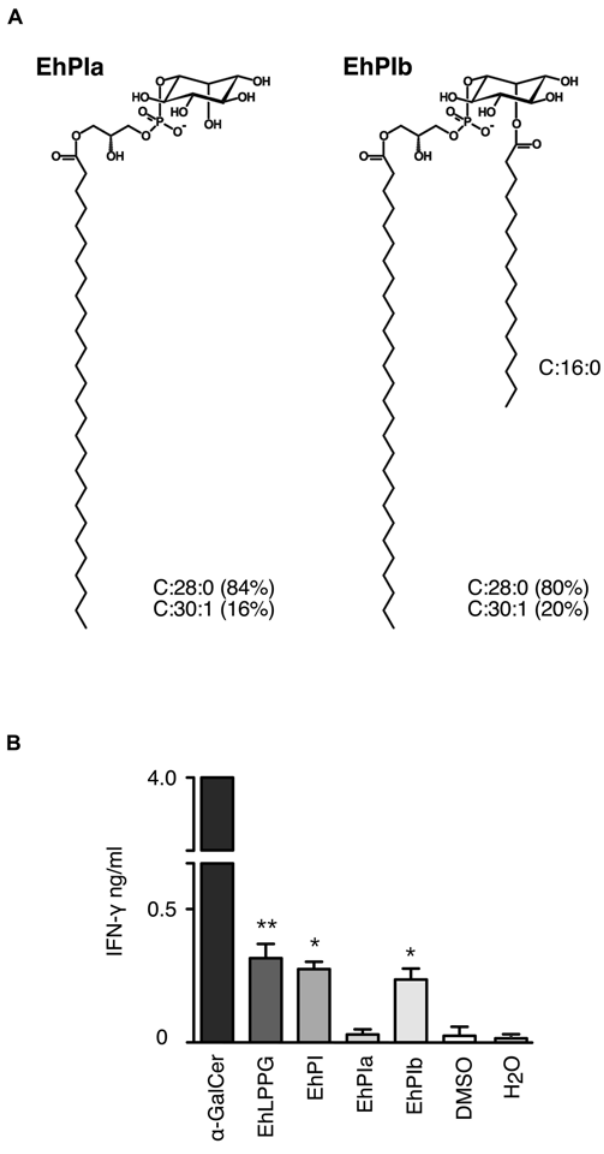
Figure 4. Structure and NKT cell stimulatory capacity of EhPIs. (A) The proposed structures of EhPIa (left) and EhPIb (right). The only difference between the EhPIs is the acylation of inositol at position 2 in EhPIb. The fatty acids and the molar ratios are indicated. (B) IFN c production of NKT cells stimulated by APCs pulsed with a -GalCer, EhLPPG, EhPI, EhPIa and EhPIb. IFN- c production compared to DMSO control * ( p , 0.05); ** ( p , 0.005); ANOVA, Dunnett. The results were obtained from three independent experiments. of EhLPPG or separated EhPIa and EhPIb, respectively, indicated that EhPIb, but not EhPIa, is the active portion of EhLPPG that contains the capacity to induce the production of IFN- c (Fig. 4 B ). To determine whether indeed NKT cells are responsible for IFN- c secretion after stimulation with EhLPPG or EhPI, lymphocytes were prepared from J a 18 2 / 2 or CD1d 2 / 2 mice lacking i NKT or all NKT subpopulations, respectively, and co- cultivated with EhLPPG- or EhPI-pulsed APC from wild-type C57BL/6 mice. Cells from both J a 18 2 / 2 and CD1d 2 / 2 mice